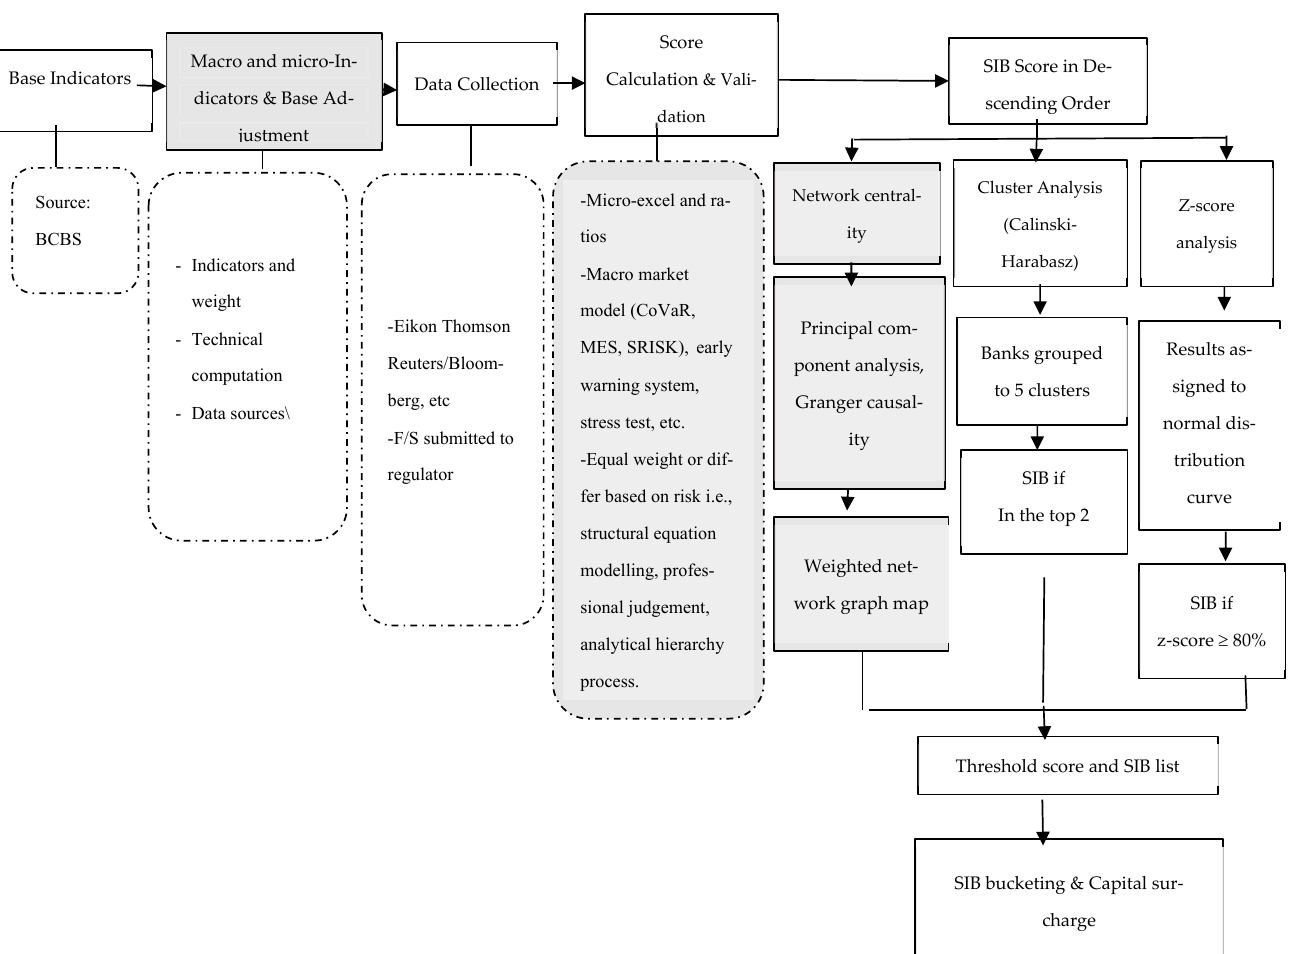
Figure 2. Assessment Framework Workflow. Source: Author adapted from OJK (2018).